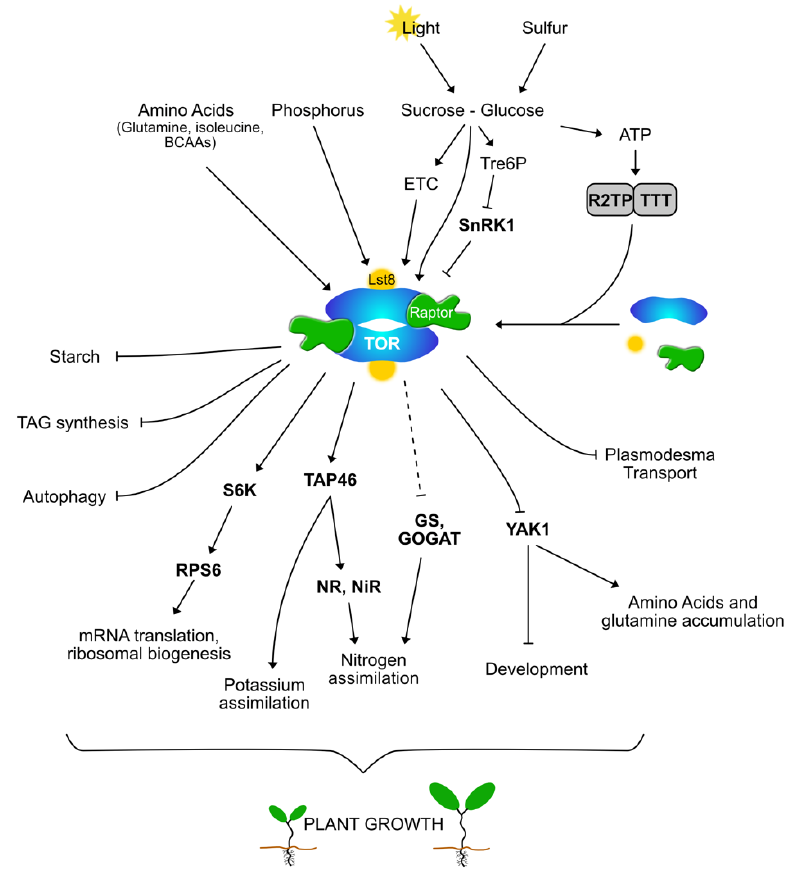
Figure 1. Regulations and outputs of the TOR signaling pathway in photosynthetic organisms: TOR is a conduc TOR of nutritional and metabolic processes. Legend: The TOR (Target of Rapamycin) protein kinase is a central regulatory hub connecting various environmental and internal signals with the plant and algal metabolic and growth processes. This kinase is the heart of the evolutionary conserved TORC1 complex in which it interacts with LST8 (Lethal with Sec Thirteen protein 8) and RAPTOR (Regulatory-Associated Protein of TOR). The association of R2TP (Pontin/RuvBL1-Reptin/RuvBL2-Spaghetti/Tah1-Pih1), TTT (Tel2-Tti1-Tti2) complex and HSP90 chaperone allow the dimerization and stabilization of the TORC1 complex depending on ATP levels. Light and photosynthesis produce sugars, which, through the ETC (Electron Transport Chain), are known to stimulate TOR activity and to inhibit SnRK1 (Snf1-Related Kinase 1), the antagonist kinase of TOR. SnRK1 is activated by low energy and nutrient conditions and phosphorylates RAPTOR, inhibiting TOR activity. Phosphorus, sulfur, nitrogen and amino acids also stimulate TOR activity. In response to these signals, TOR acts on different targets like S6K (ribosomal protein S6 kinase), YAK1 (Yet another Kinase 1) or TAP46 (PP2A regulatory subunit TAP46) to regulate mRNA translation, nutritional and metabolic processes and in fine plant growth.